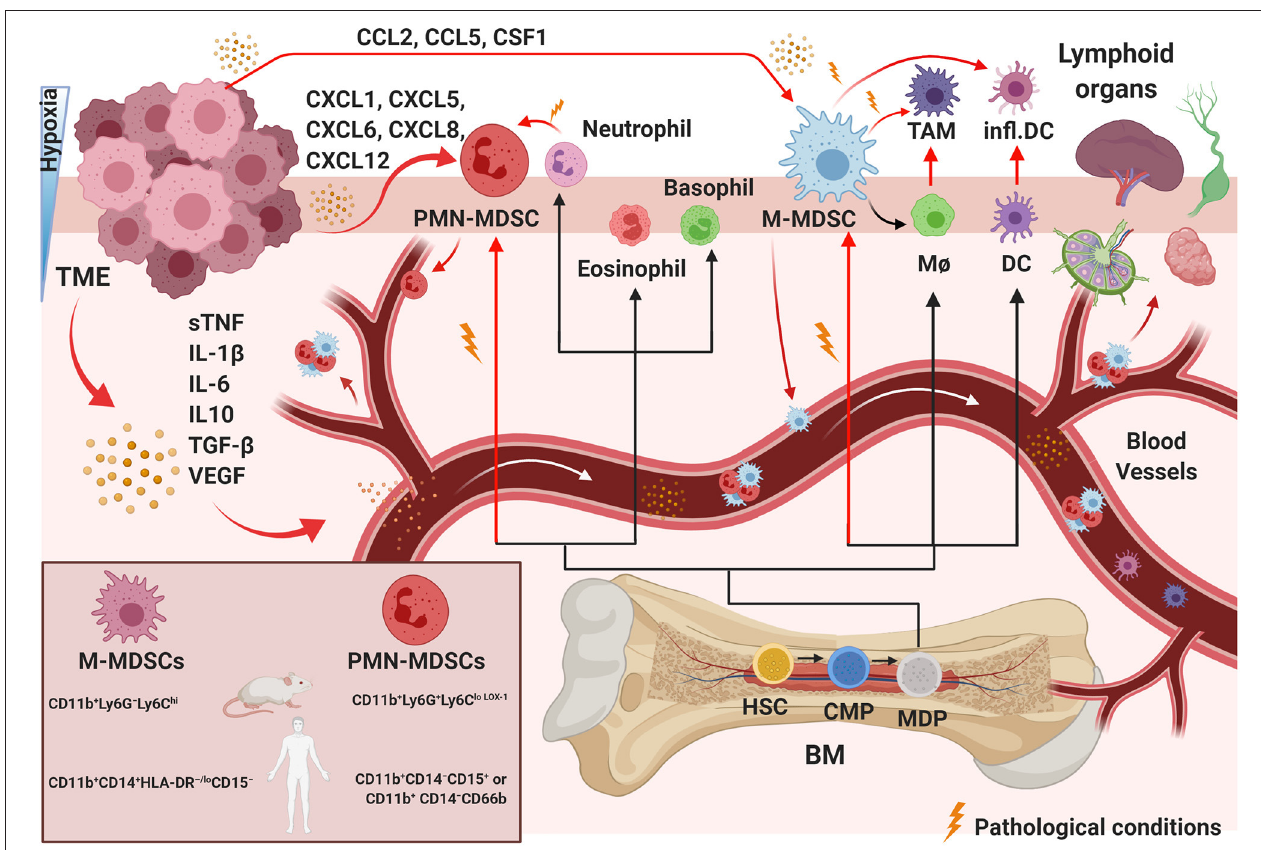
FIGURE 1 | Pathological myelopoiesis in cancer. Under physiological conditions and chronic inflammation, hematopoietic progenitor cells (HPCs) differentiate via common myeloid progenitor cells (CMPs) into monocytic/dendritic progenitor cells (MDPs). Myelopoiesis is altered under pathological conditions, such as in a tumor. Tumor-immunosuppressive factors produced in the TME alter myelopoiesis, leading to aberrant differentiation and accumulation of myeloid lineage cells. The black lines show the normal pathways of myeloid cell differentiation from immature myeloid precursor cells to dendritic cells (DCs), macrophages (M 8 ), and granulocytes, as depicted. The red lines indicate the aberrant pathways of myeloid cell differentiation that arise in cancer, in which the TME promotes the development of immunosuppressive populations, including monocytic myeloid-derived suppressor cells (M-MDSCs), polymorphonuclear myeloid-derived suppressor cells (PMN-MDSCs), inflammatory DCs, and tumor-associated macrophages (TAMs). The MDSC mouse and human phenotypes are shown in the left square on the bottom. BM, bone marrow; sTNF, soluble tumor necrosis factors. Created with BioRender.com.